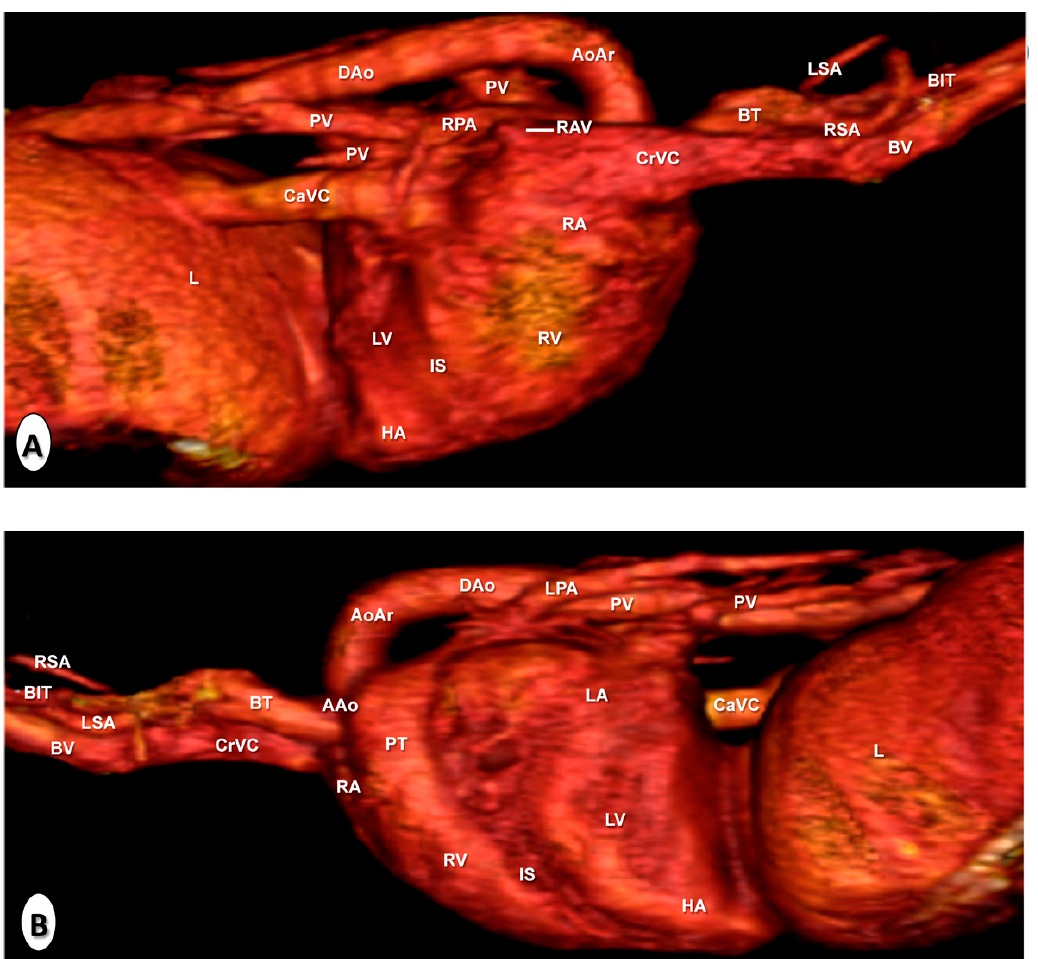
Figure 9. Three-dimensional volume-rendered reconstructed images of the normal neonatal foal heart and associated blood vessels. Parasagittal aspects. ( A ) Right lateral aspect and ( B ) left lateral aspect. Aortic arch (AoAr); ascending aorta (AAo); bicarotid trunk (BIT); brachiocephalic trunk (BT); brachiocephalic vein (BV); caudal vena cava (CaVC); cranial vena cava (CrVC); descending aorta (Dao); heart apex (HA); left atrium (LA); left pulmonary artery (LPA); left subclavian artery (LSA); left ventricle (LV); liver (L); pulmonary trunk (PT); pulmonary vein (PV); right atrium (RA); right azygos vein (RAV); right pulmonary artery (RPA); right subclavian artery (RSA); and right ventricle (RV).